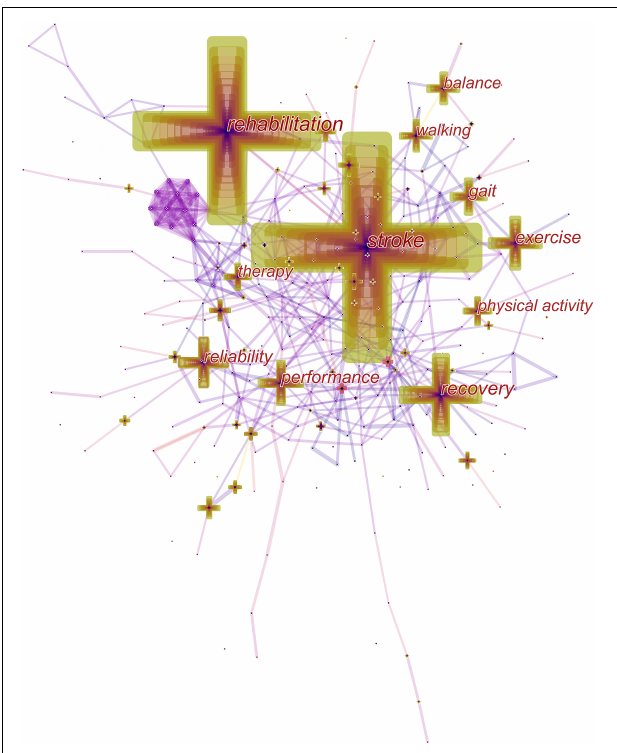
FIGURE 6 | Co-occurrence network of